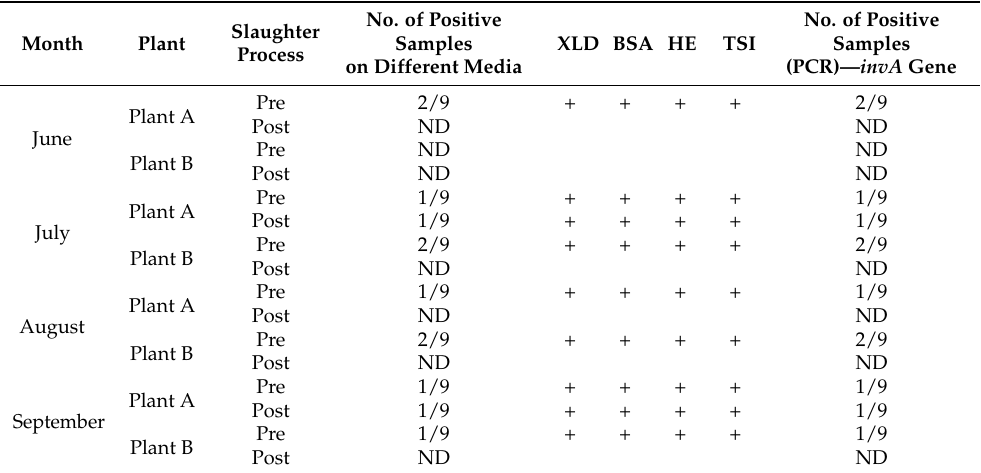
Table 2. The occurrence of presumptive Salmonella spp. in beef carcasses during slaughter processes in two plants (June–September